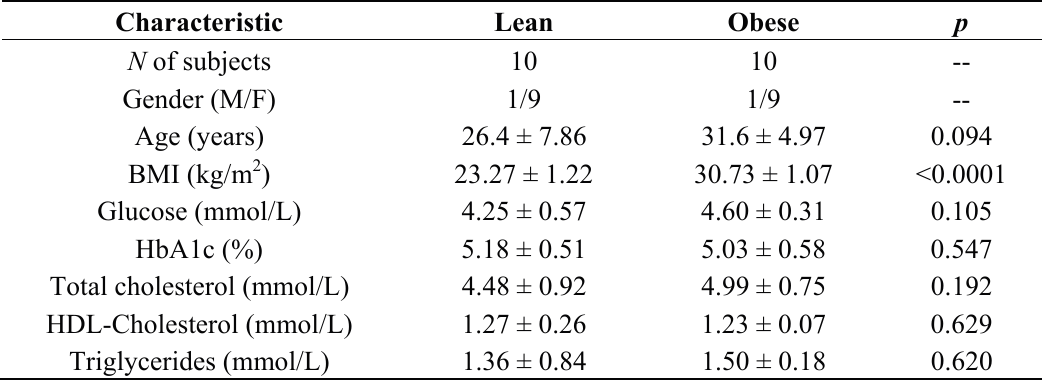
Table 1. Baseline characteristics of the study